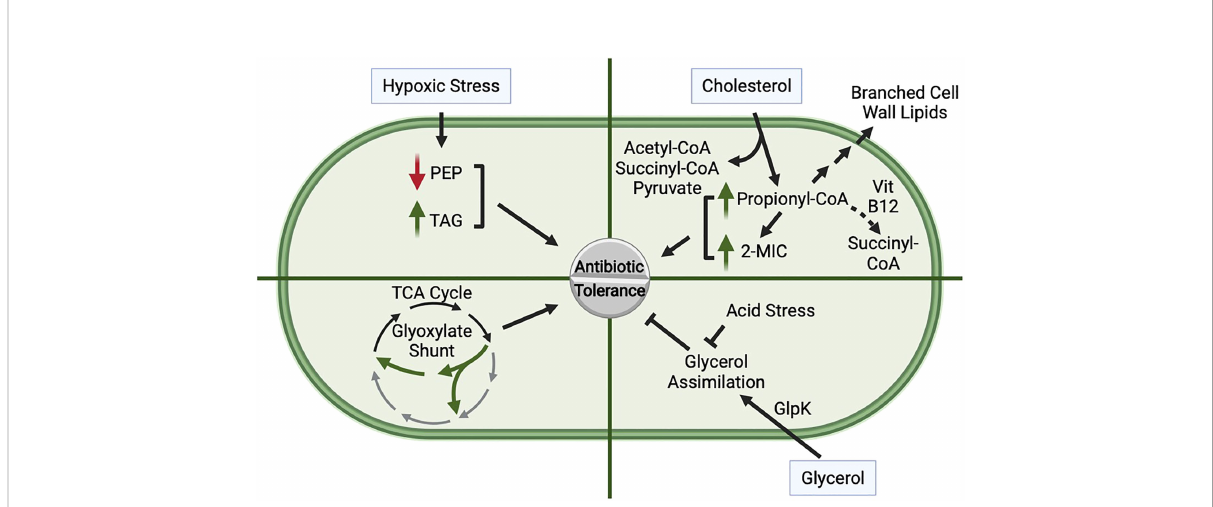
FIGURE 2 Role of Central Carbon Metabolism in Promoting Antibiotic Tolerance. Hypoxic stress, cholesterol metabolism, glycerol assimilation, low pH, and shunting of the TCA cycle via the glyoxylate shunt can each impact antibiotic tolerance of Mtb. Hypoxia: Exposure of Mtb to hypoxia leads to decreased levels of phosphoenolpyruvate (PEP) and an accumulation of triacylglycerol (TAG), both of which lead to an increase in drug tolerance. Cholesterol: Cholesterol is catabolized to acetyl-CoA, succinyl-CoA, pyruvate, and propionyl-CoA. Propionyl-CoA is detoxi fi ed through multiple pathways, including assimilation into branched chain lipids, conversion to succinyl-CoA through a vitamin B12-dependent pathway, or through the methylcitrate cycle (MCC) in which methylisocitrate (2-MIC) is an intermediate. Supplementation with cholesterol, propionate, or 2-MIC promotes antibiotic tolerance, and mutant strains that accumulate elevated levels of propionyl-CoA or 2-MIC are more tolerant to antibiotics. Glycerol Assimilation: Glycerol is assimilated into glycolysis and gluconeogenesis through phosphorylation by GlpK. Loss of glycerol catabolism leads to increased drug tolerance, suggesting that glycerol assimilation antagonizes antibiotic tolerance. Furthermore, Mtb in low pH is unable to ef fi ciently catabolize glycerol, likely due to defects in glycolysis, resulting in increased antibiotic tolerance. Glyoxylate Shunt Activity: Mutants that lack the glyoxylate shunt are more sensitive to antibiotics, suggesting that rerouting carbon through the glyoxylate shunt promotes antibiotic